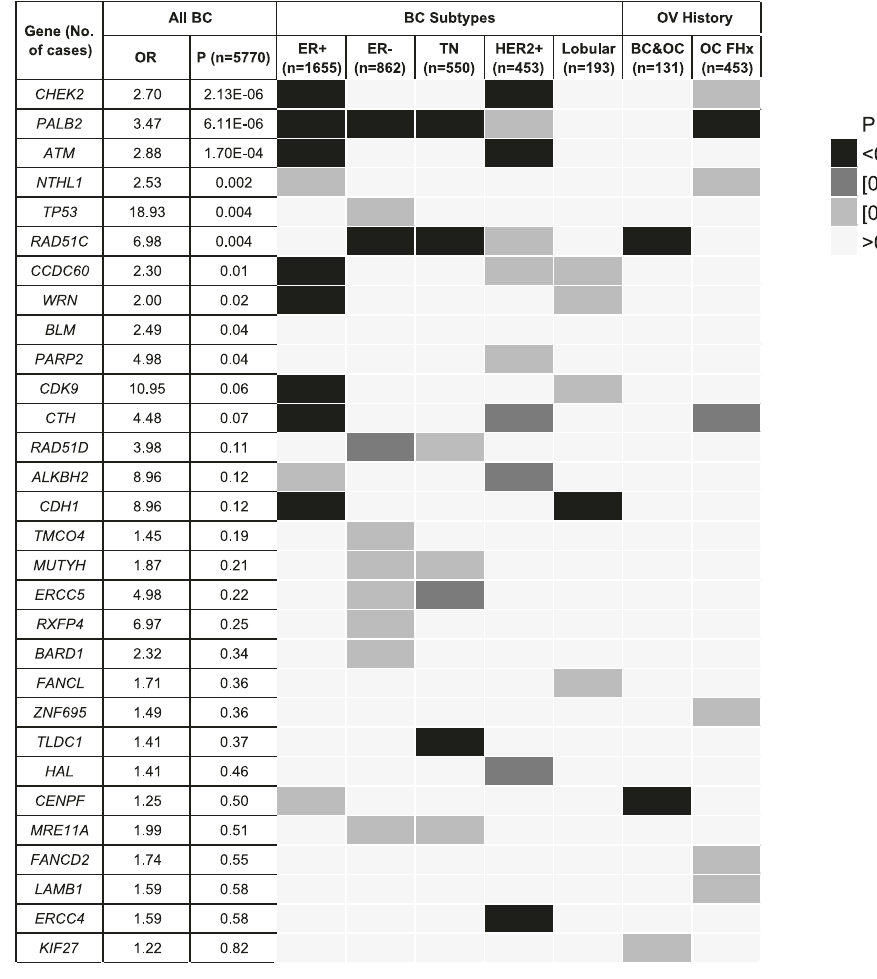
Fig. 5 Heatmap of the associations of the candidate genes with speci fi c subtypes of BC or a personal or family history of OC. Only LoF variants were considered in the analysis for candidate genes and HBOC genes ( N = 159) in cases from ViP cohort and controls, and genes with one or more statistically signi fi cant associations ( p < 0.05, Fisher ’ s exact test, two-sided) are